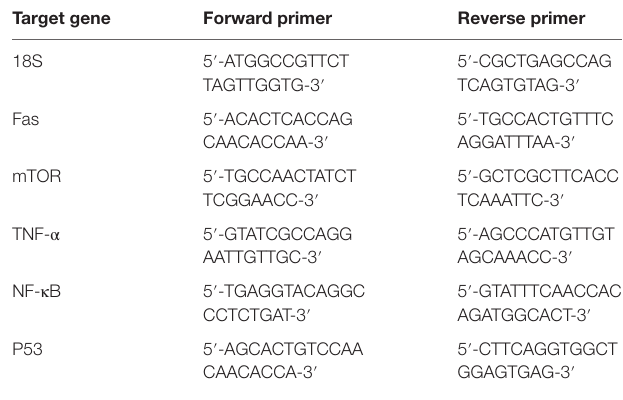
Table 1 | Target genes and terminal primers used in the qPCR